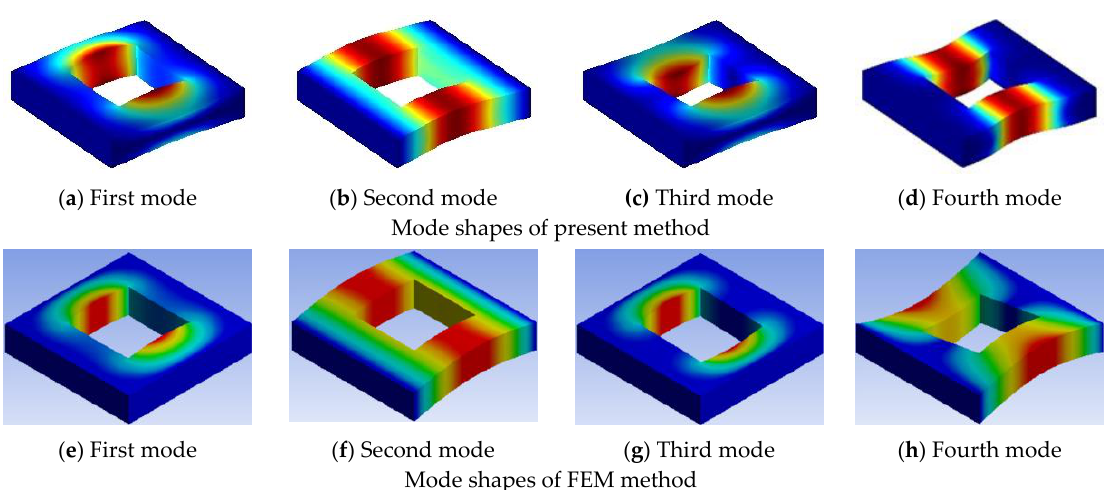
Figure 4. First four mode shapes of (0°/90°/90°/0°) laminated square plate with CSCS boundary condition for a cutout size ratio of 0.5.